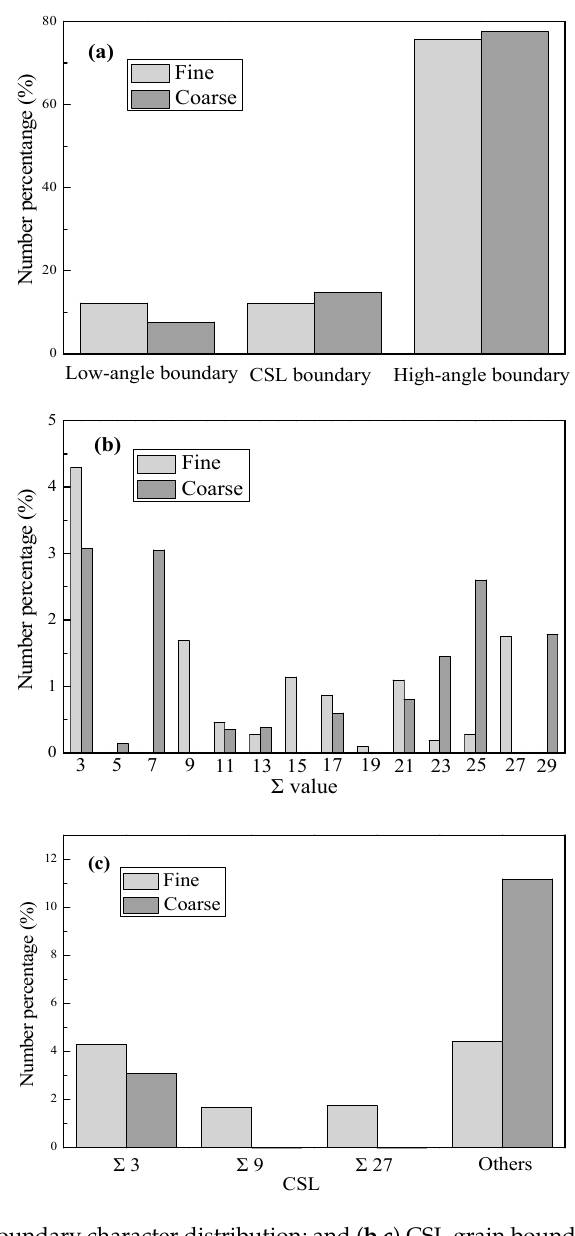
Figure 8. ( a ) Grain boundary character distribution; and ( b , c ) CSL grain boundary distribution in the IF steel specimens with the grain sizes of 48 and 225 µm, respectively.